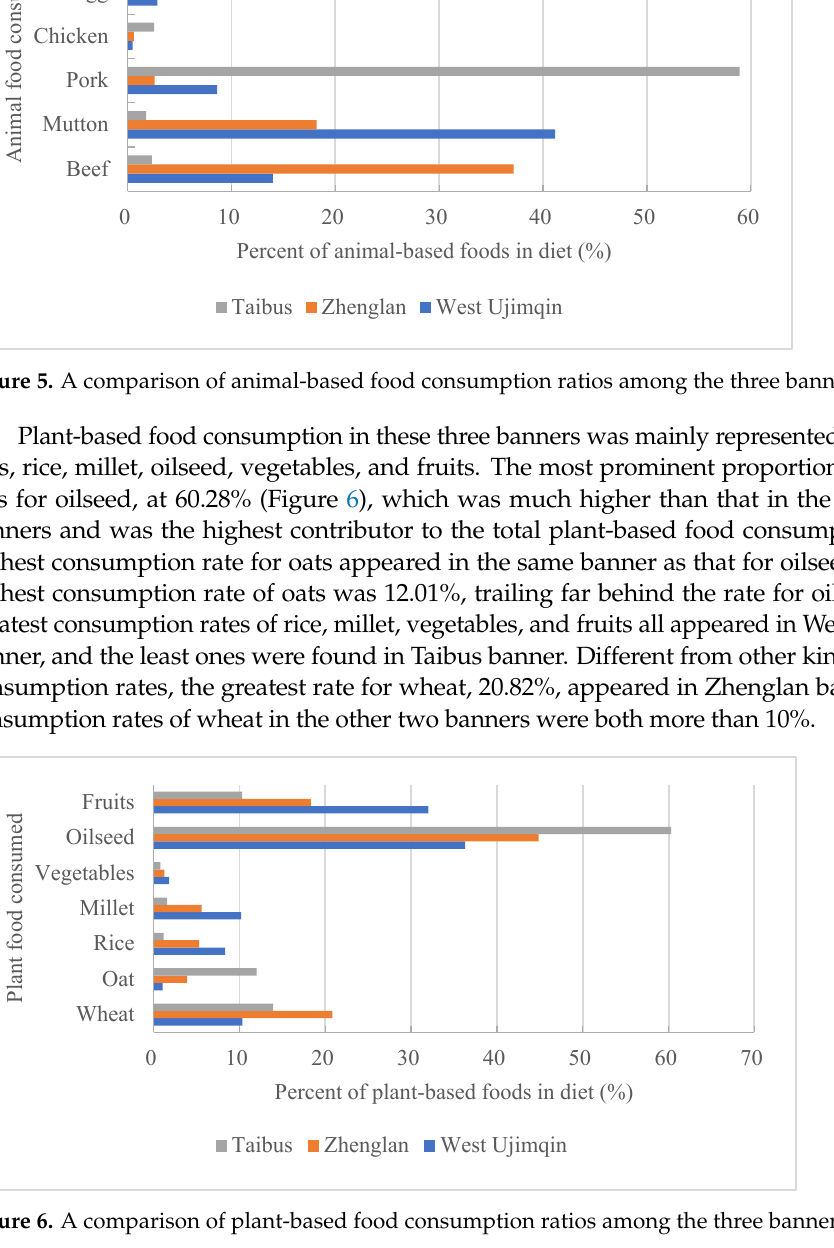
Figure 6. A comparison of plant-based food consumption ratios among the three banners.